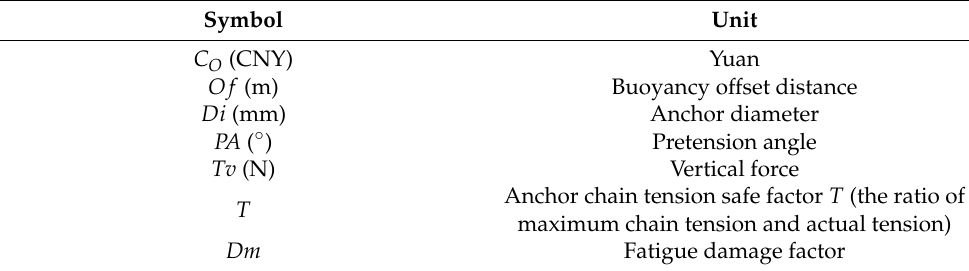
Table A1. List of all parameters with units.